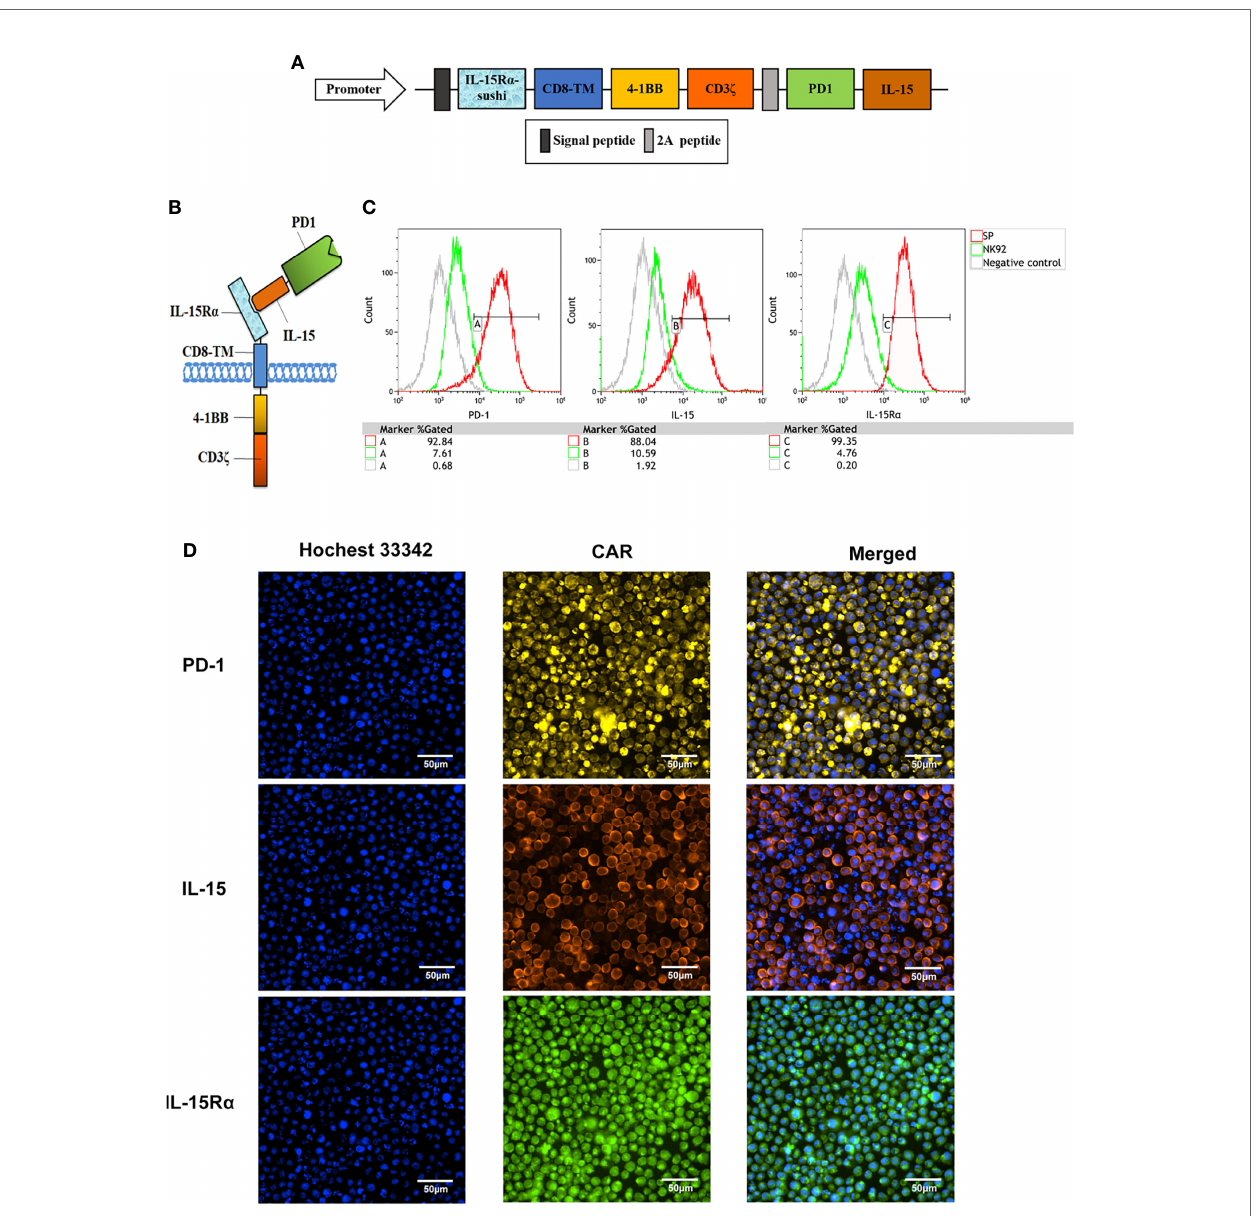
FIGURE 1 | Establishment of a novel sushi-IL15-PD1 CAR-NK92 cell line (SP). (A) Sequential expression cassette diagram of the chimeric antigen receptor (CAR), including signal peptide, IL-15R a -sushi, CD8 transmembrane domain, signal transduction domain of 4-1BB and CD3 z , 2A peptide, PD1 extracellular domain and IL-15. (B) Structure diagram of the protein expression pattern of the CAR gene. (C) Surface expression of programmed cell death 1 (PD-1), IL-15R a , and IL-15 in SP and NK92 cells was analyzed by fl ow cytometry (FCM). (D) Cellular immuno fl uorescence detection of CAR molecules localized and expressed on SP cell